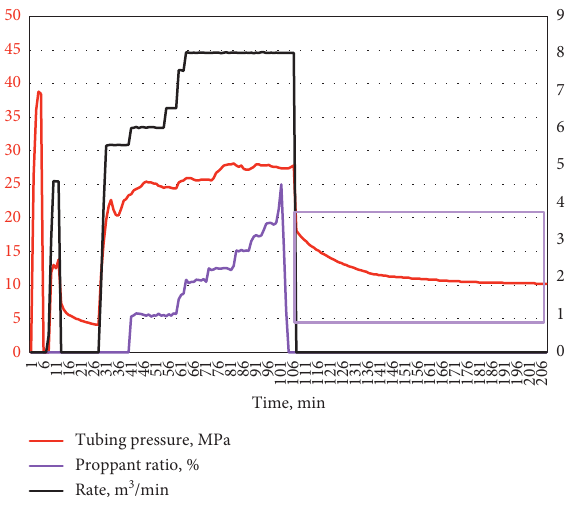
Figure 7: The original data of the operation